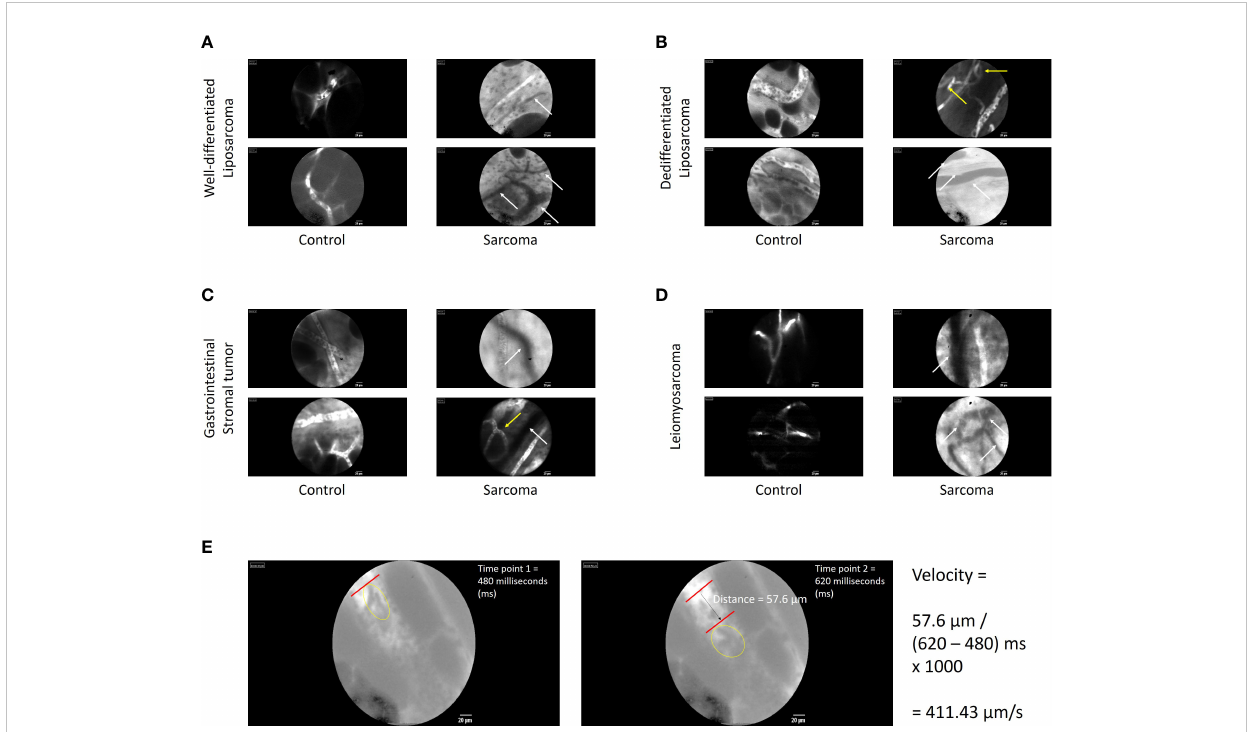
FIGURE 1 Images of tumor and non-tumor vessels among individual patients with sarcoma. Observations of sarcoma-associated vessels from well- differentiated (A) and dedifferentiated (B) retroperitoneal liposarcomas, gastrointestinal tumors (C) , and leiomyosarcomas (D) are depicted for both control and sarcoma areas. Similar to our previous clinical trials in melanoma and peritoneal carcinomatosis, aberrant and non-functional sarcoma- associated vessels could be observed using our intravital microscope. Arrows highlight qualitative differences between normal and sarcoma- associated vessels. White arrows highlight nonfunctional vessels (absence of fl uorescent dye uptake). Yellow arrows indicate aberrant loop or branch patterns. (E) Example calculation of how blood fl ow velocity was observed and estimated by tracking a distinct cluster of red blood cells traveling through a functional blood vessel in a visualized normal (control) area for a patient with a dedifferentiated liposarcoma. The left frame shows the cluster of interest (within yellow oval) at fi rst time point. The right frame shows the same cluster traveling a measurable distance with the blood vessel. The velocity calculation is shown to derive velocity in m